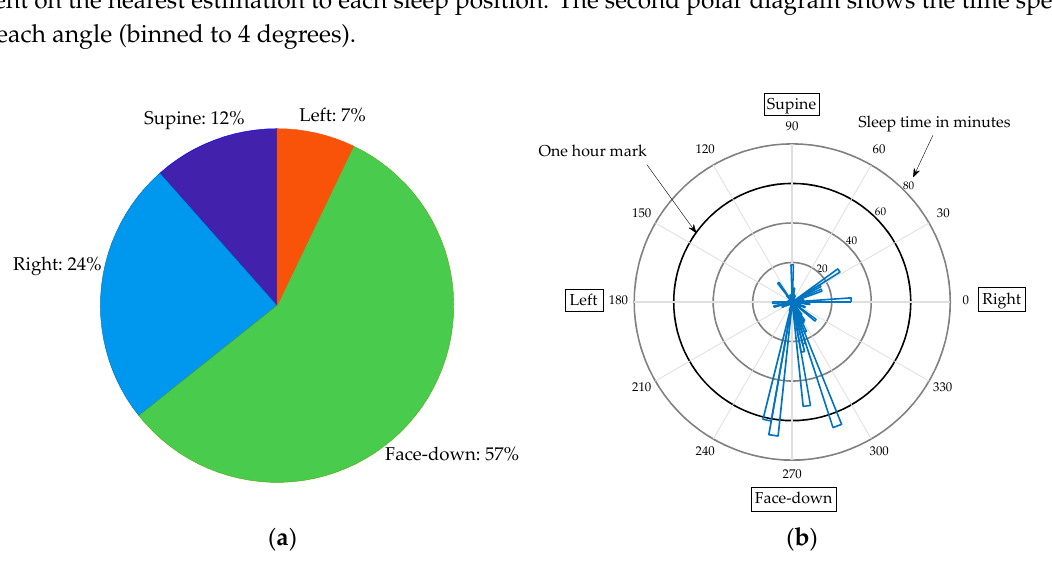
Figure 9. Summary of sleep position from a full night recording. ( a ) Percentage of time spent in each position. ( b ) A polar diagram showing sleep angle versus sleep time in minutes.